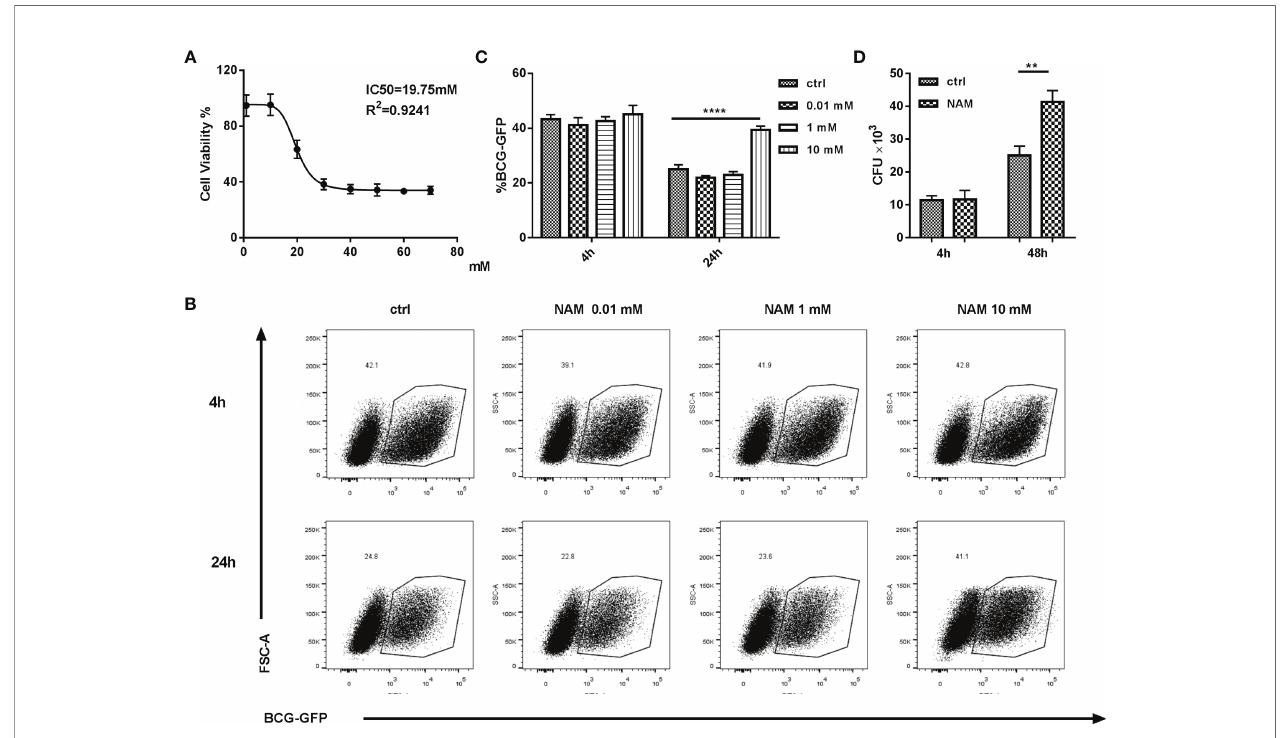
FIGURE 2 | SIRT7 inhibitor NAM increases Mycobacteria burden in Raw264.7 cells. (A) Dose-dependent cytotoxicity and IC 50 values of NAM in Raw264.7 cells. (B, C) Raw264.7 cells were pretreated with the indicated doses of NAM 24 h before infection with BCG-GFP (MOI 10:1), and then analyzed by fl ow cytometry at 4h and 24 h after infection. Representative fl ow cytometry images of BCG-GFP-positive Raw264.7 cells were captured (B) and the percentage of cells positive for GFP were calculated using Flow Jo software (C) . (D) Colony-forming unit (CFU) counts from Raw264.7 cells treated with or without NAM (10 mM) after 4h and 48h infected with H37Rv. Data represent means ± SD for three independent experiments. Two way ANOVA was performed in (C, D). **p < 0.01; ****p<